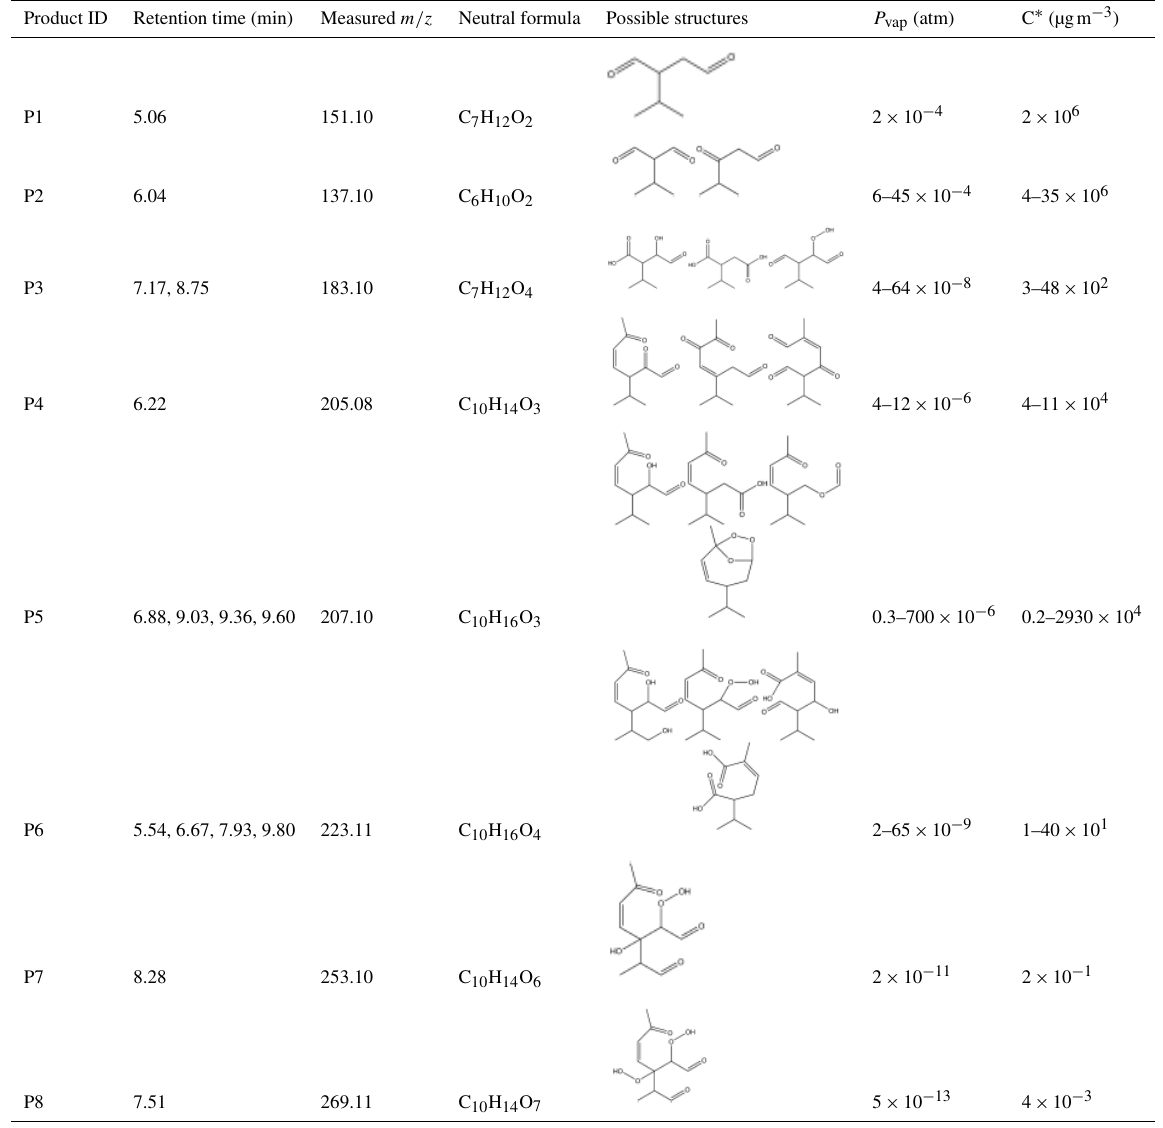
Table 3. Major species detected in positive mode ESI with postulated structures consistent with composition and the mechanism proposed by Mackenzie-Rae et al. (2017), along with estimated saturation vapour pressures ( P vap ) and saturation vapour concentrations (C ∗ ). Proposed structure list is not exhaustive, with other isomers